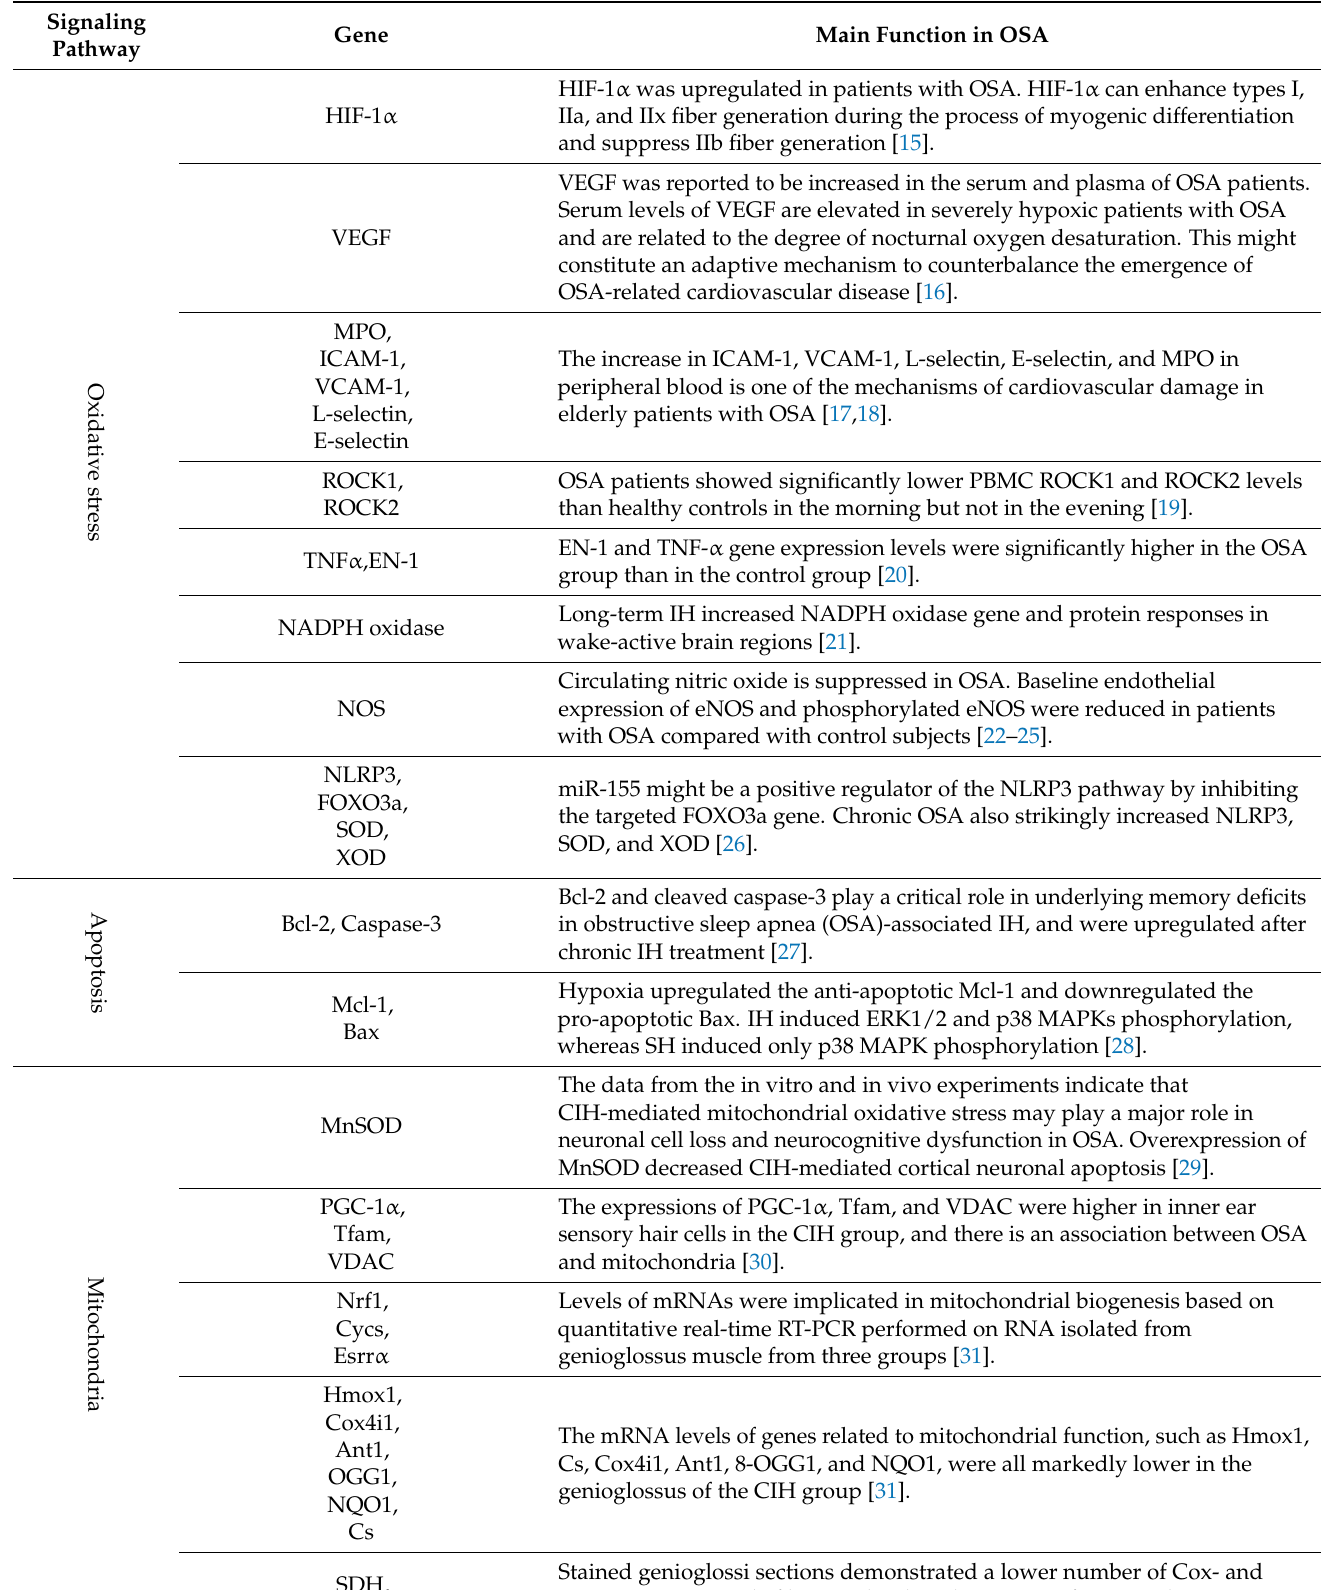
Table 1. Genes involved in